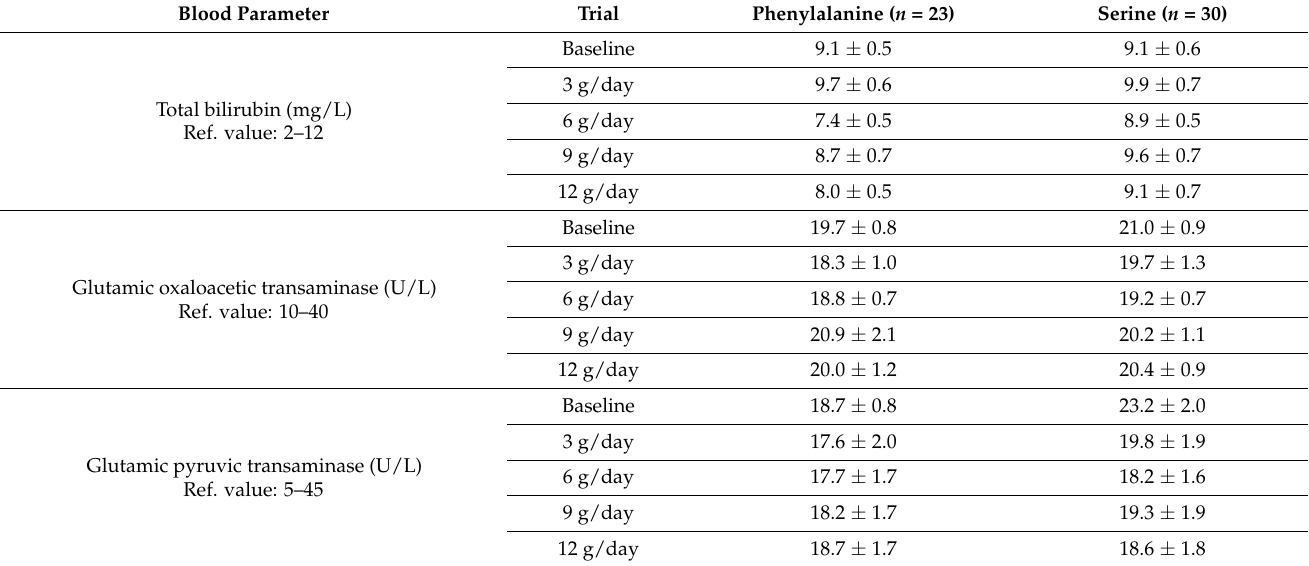
Table 1. Changes in biochemical blood parameters throughout the oral phenylalanine or serine supplementation period in healthy